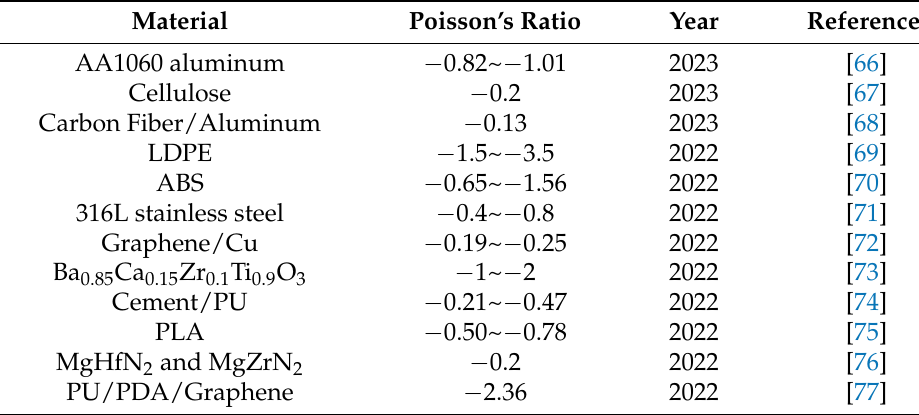
Table 1. AXSs previously investigated and their Poisson